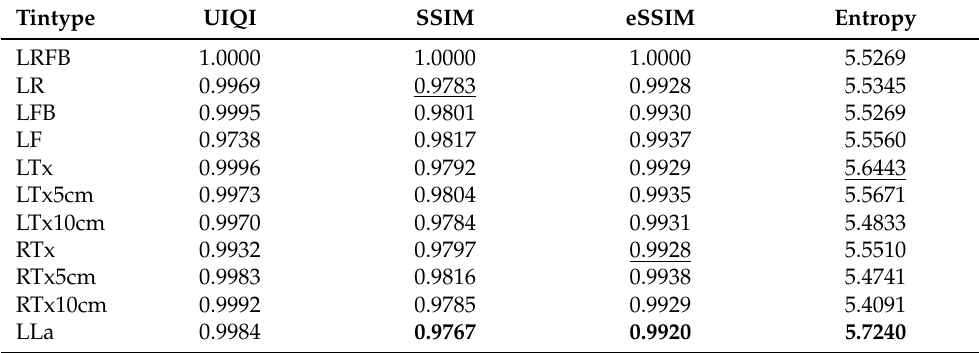
Table 5. Tintype. Comparison of images scanned in different scan modes with a reference image scanned in LRFB mode.